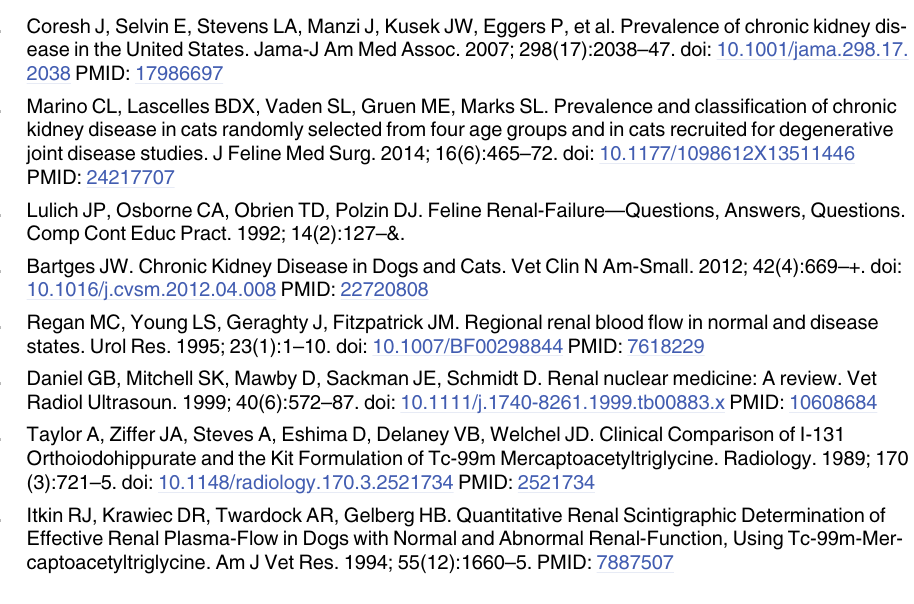
scintigraphy parameters. Percentage 3